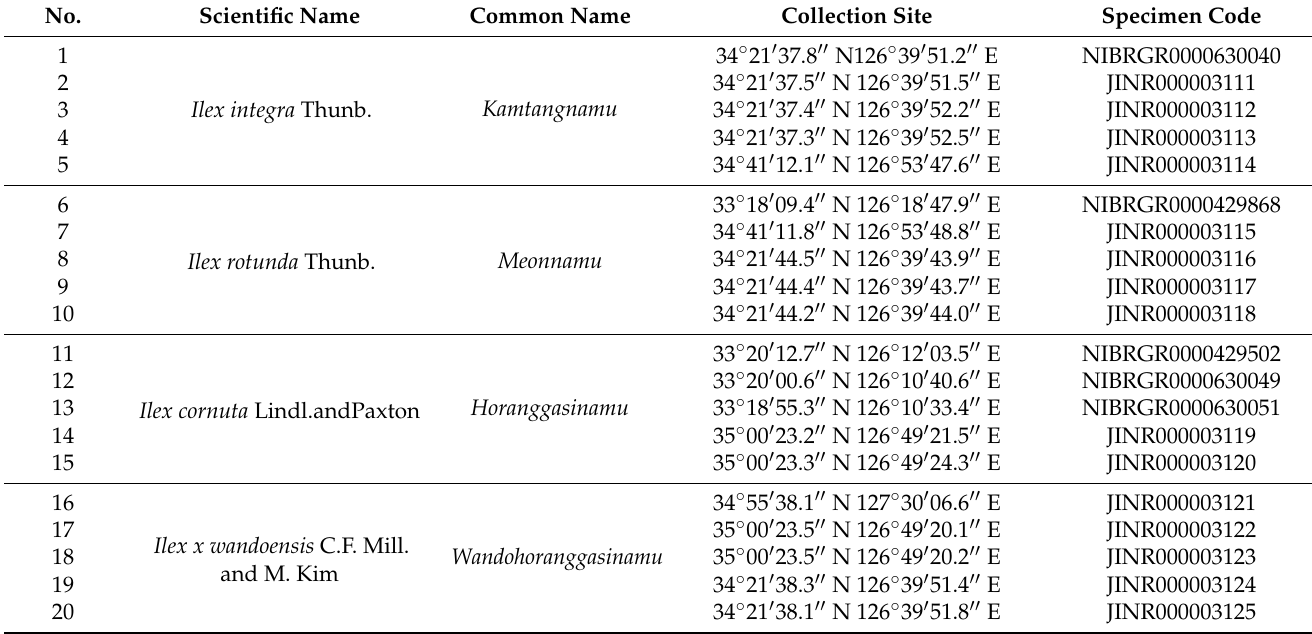
Table 1. Ilex specimens used in this